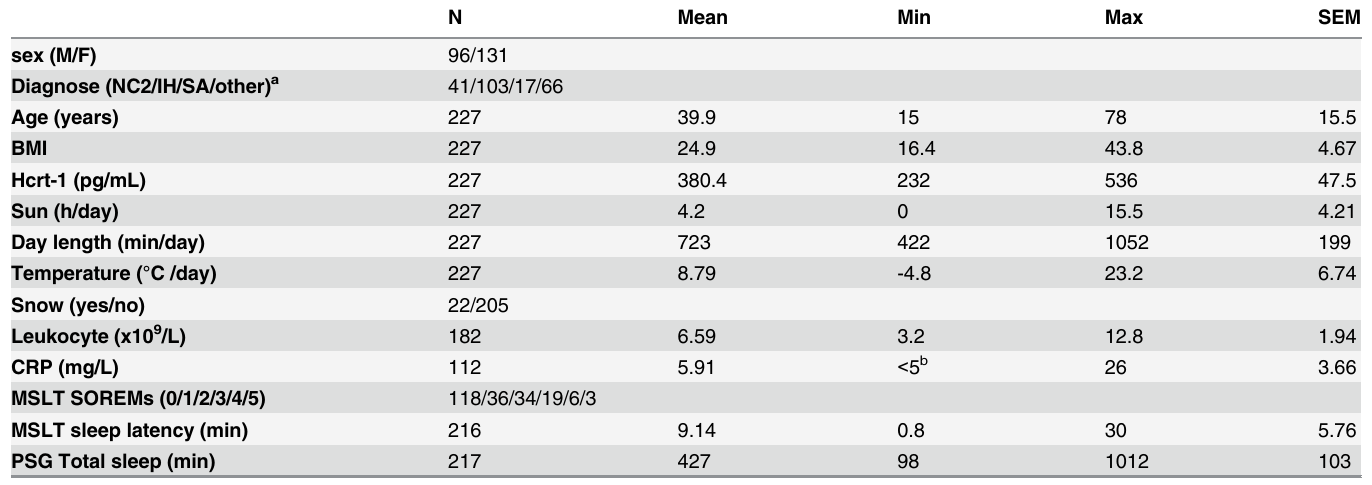
Table 1. Summary of variables in the